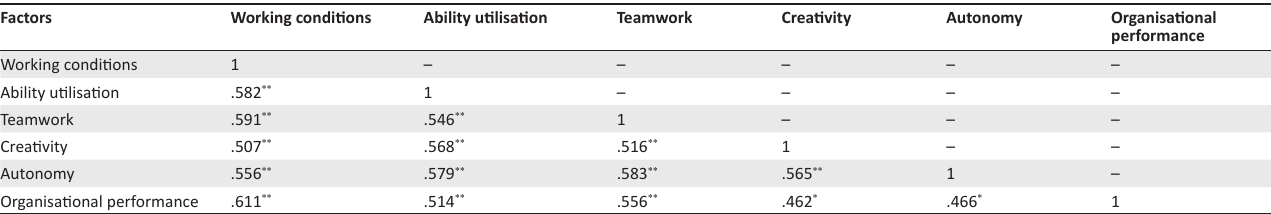
TABLE 3: Correlations: Employee satisfaction and organisational performance.